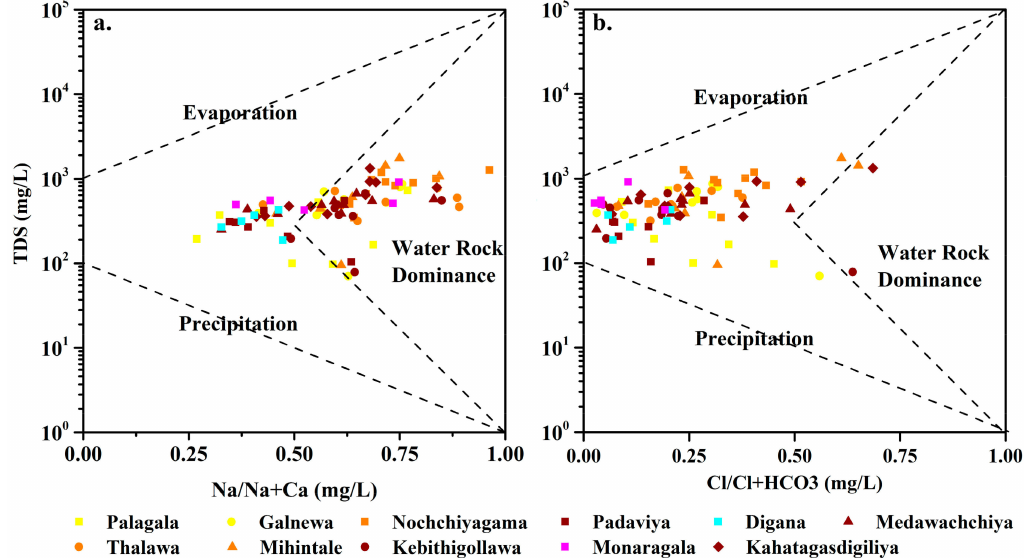
Figure 1. Gibbs plots of groundwater samples from di ff erent chronic kidney disease of unknown etiology (CKDu) prevalence areas in wet season. ( a ) Variation of weight ratio of Na / (Na + Ca) as a function of total dissolved solids, ( b ) variation of weight ratio of Cl / (Cl + HCO 3 ) as a function of